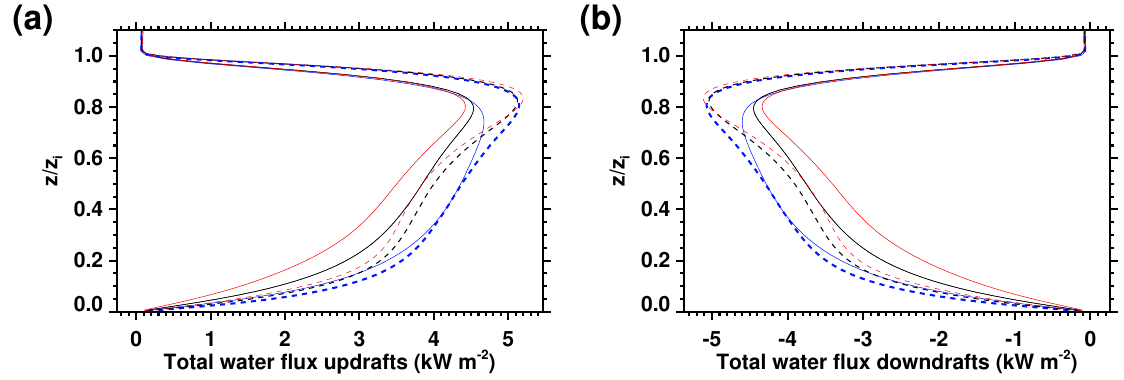
Figure C9. Effect of resolution. Profiles averaged over 1h in the period C (22:30–23:30UT) from simulations M − (blue), M 0 (black), M + (red), solid curves, and from simulations M − surface area of the domain.